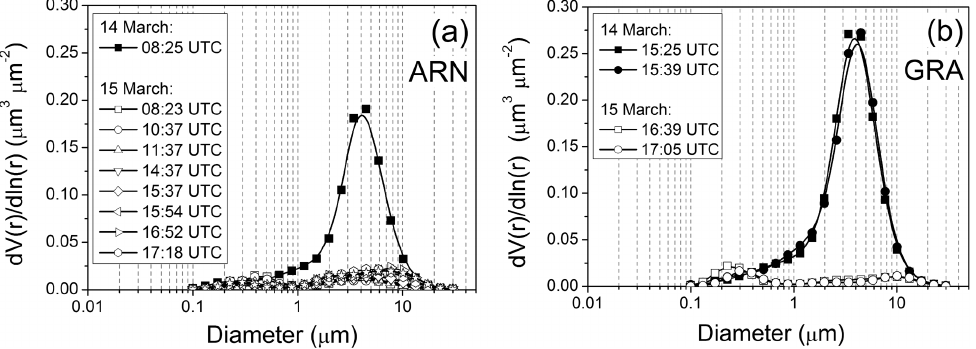
Fig. 4. AERONET columnar-integrated volume size distributions (VSD AERONET ) at available times on 14 March (dusty day, full symbols) and 15 March (non-dusty day, open symbols) in ARN (a) and GRA (b)